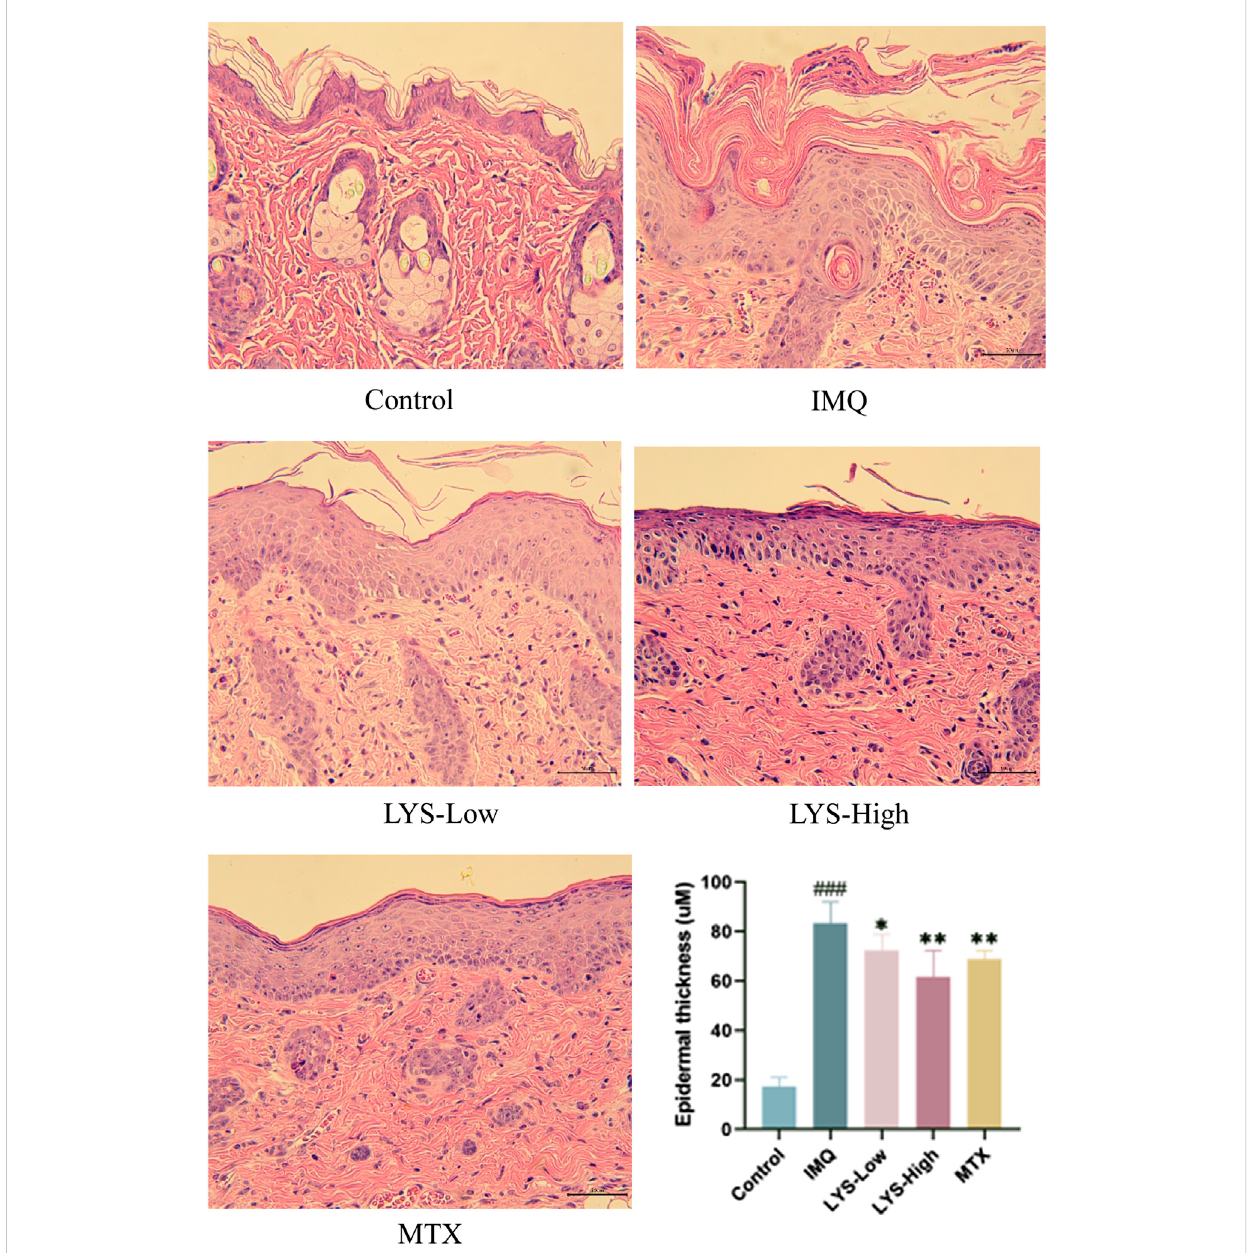
FIGURE 3 Histopathological images andepidermal thickness ofdifferentmice (imagesmagni fi ed×100, n =7).ImagesofH andE-stainedsectionsweretaken under a microscope to observe the epidermal thickness in different groups. Three fi elds were selectedfor each image, and every fi eld was measured fi ve times. ### p < 0.001 vs. the control group; * p < 0.05, ** p < 0.01, and *** p < 0.001 vs. the IMQ